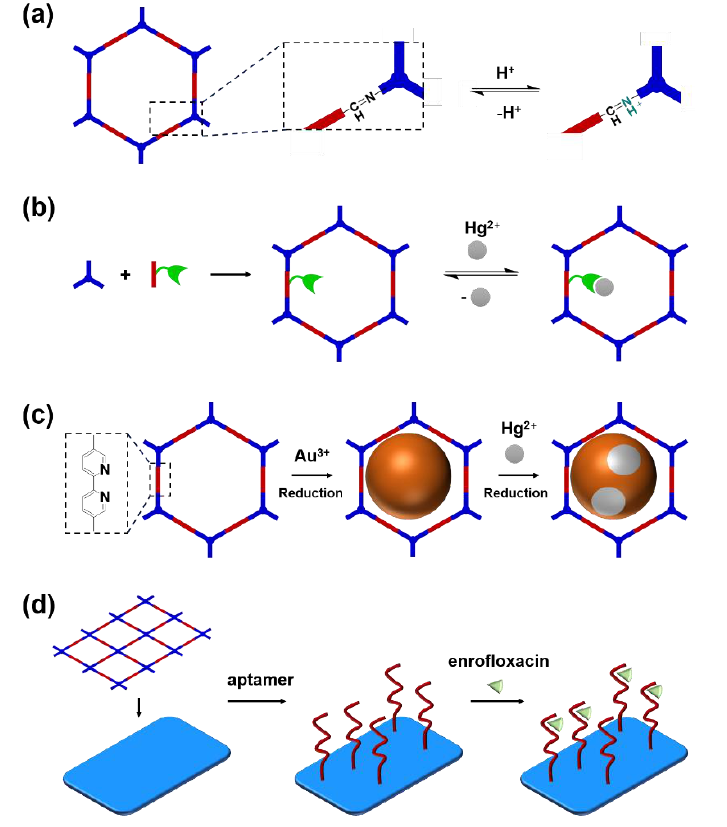
Figure 3. Introducing the binding site that can selectively capture the analyte. ( a ) capturing H + by imine linkage; ( b ) Intruding thioether binding site for capturing Hg 2+ ; ( c ) Introducing AuNPs by in situ growth for mercury capture; ( d ) Externally immobilizing enrofloxacin-targeted aptamer onto the 2D sheet of the COF for capturing enrofloxacin.